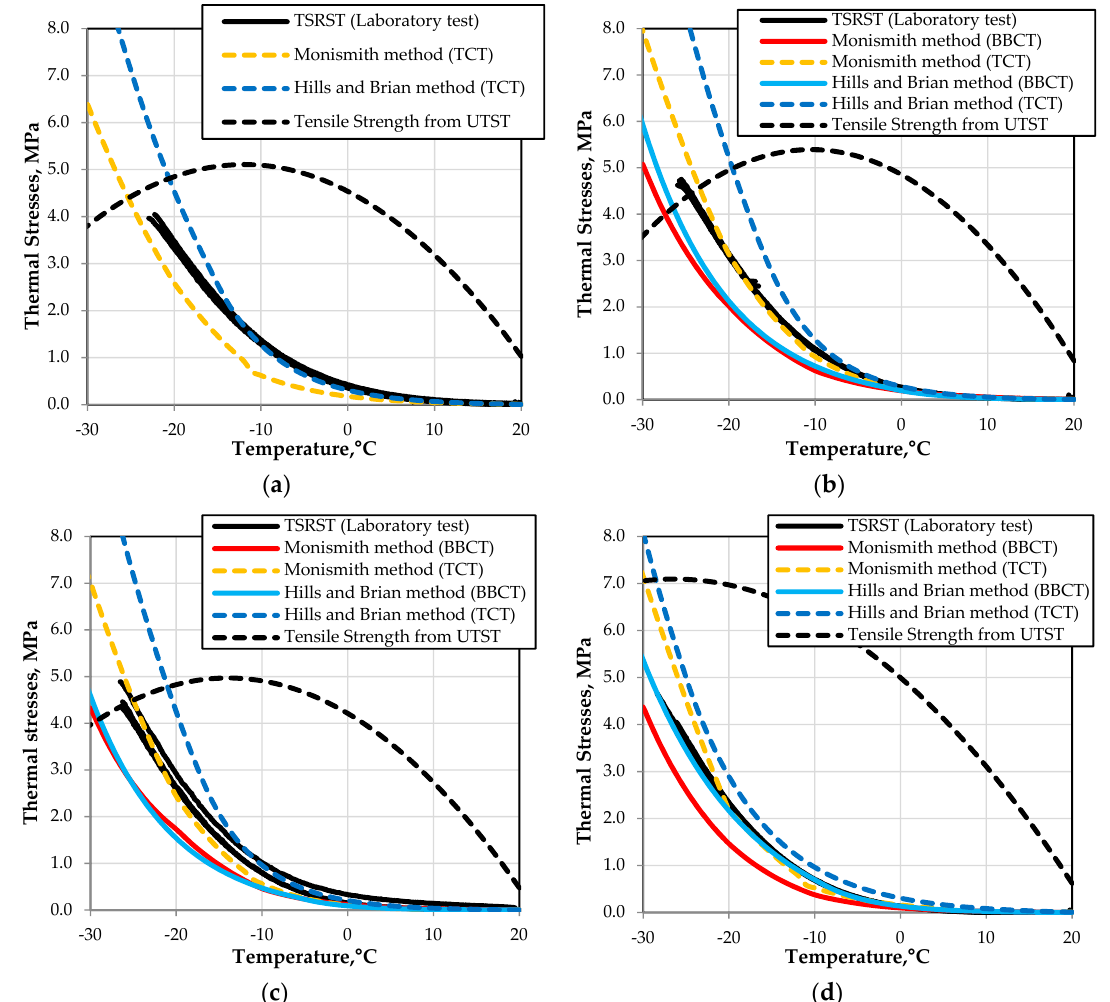
Figure 16. Results of calculation of thermal stresses for all the tested mixtures in comparison to the TSRST and UTST results, temperature gradient of 10 °C/h: ( a ) AC 11W 35/50 MT ( b ) AC 11S 50/70 MT